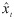
Estimation of simulated motion from strip-registration lag biases.Traces of the simulated eye position are plotted with solid lines, separately for horizontal (left) and vertical (right) components. The lag bias estimates x^t and y^t are plotted with dashed lines. Estimates bear qualitative similarity to the simulated movement trace, consistent with high goodnesses of fit to the simulated movement trace (Rx2=0.96 and Ry2=0.96).